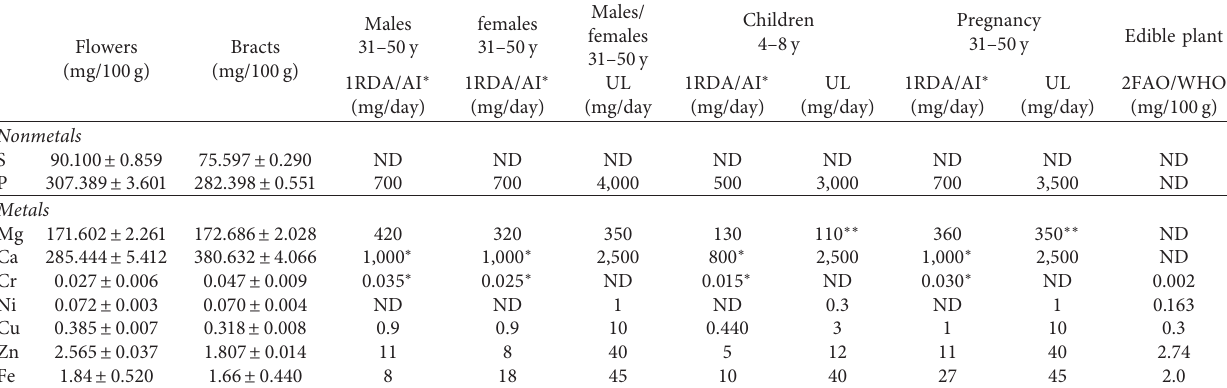
Table 6: Nonmetals and heavy metals quantified in banana inflorescences (flowers and bracts) compared to nutritional recommendations for adults, children, and